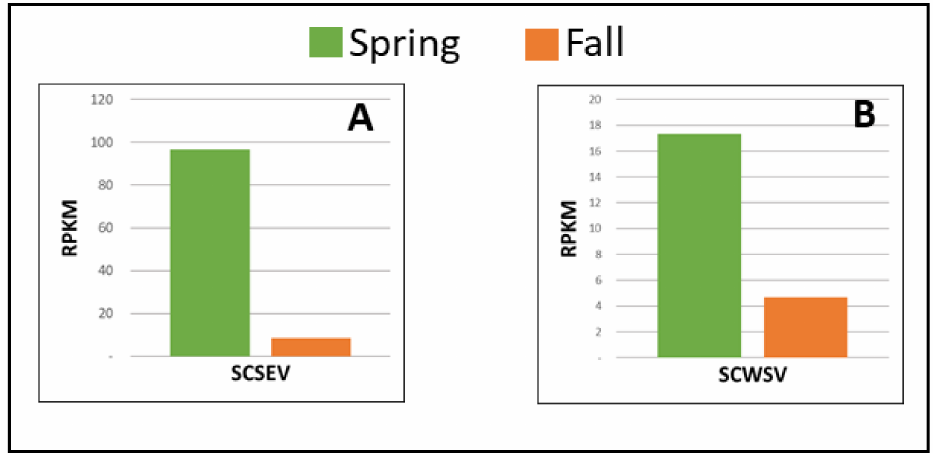
Figure 3. Spring and fall viral read comparison of two DNA viruses in sugarcane quarantine speci- mens. Viral reads are normalized as RPKM, reads per kilobase per million, to account for viral genome size [43]: ( A ) sugarcane streak Egypt virus (SCSEV); ( B ) sugarcane white streak virus